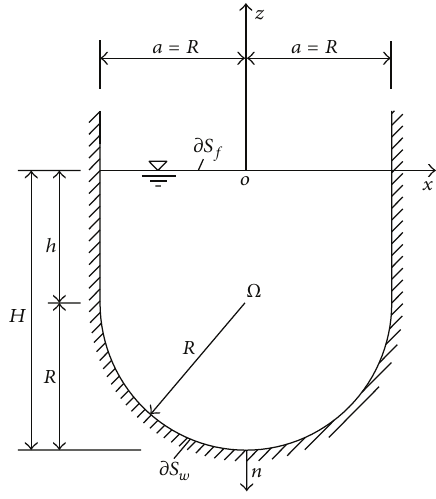
Figure 8: A U-shaped section